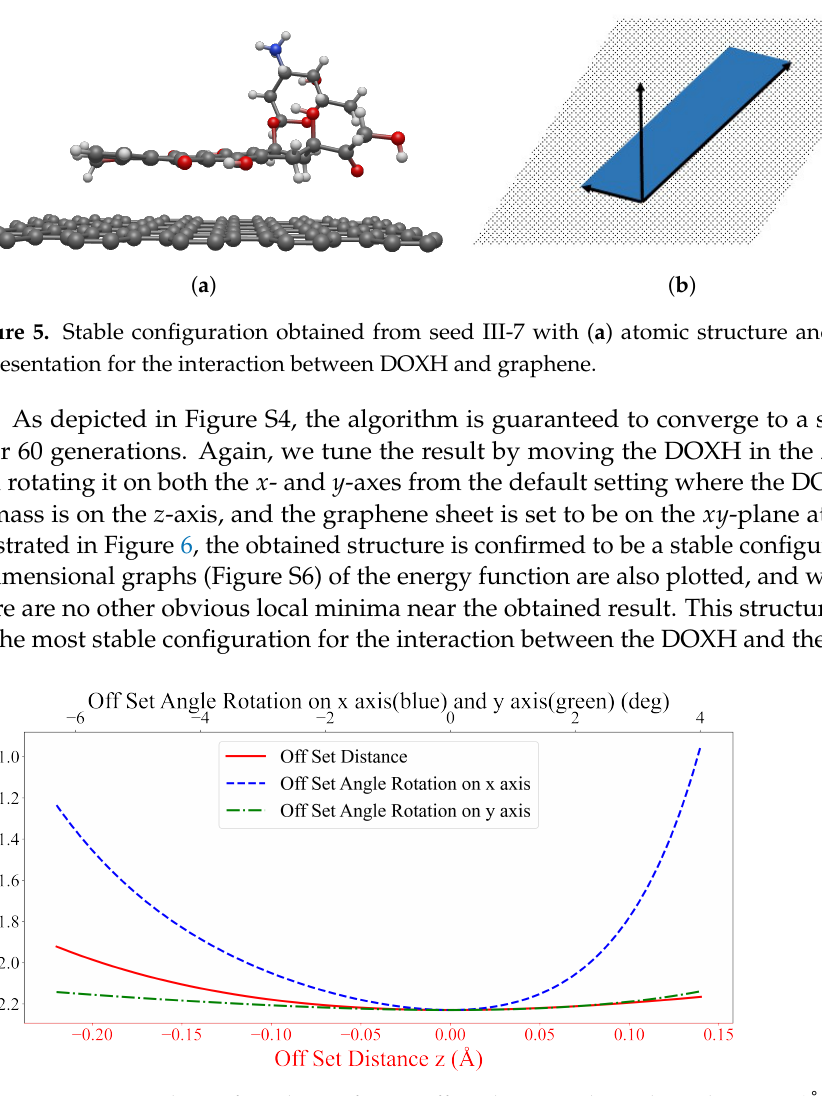
Figure 6. Energy values of seed III-7 for an offset distance along the z -direction (Å) and offset rotational angles (degrees) on the x - and y -axes for DOXH interacting with